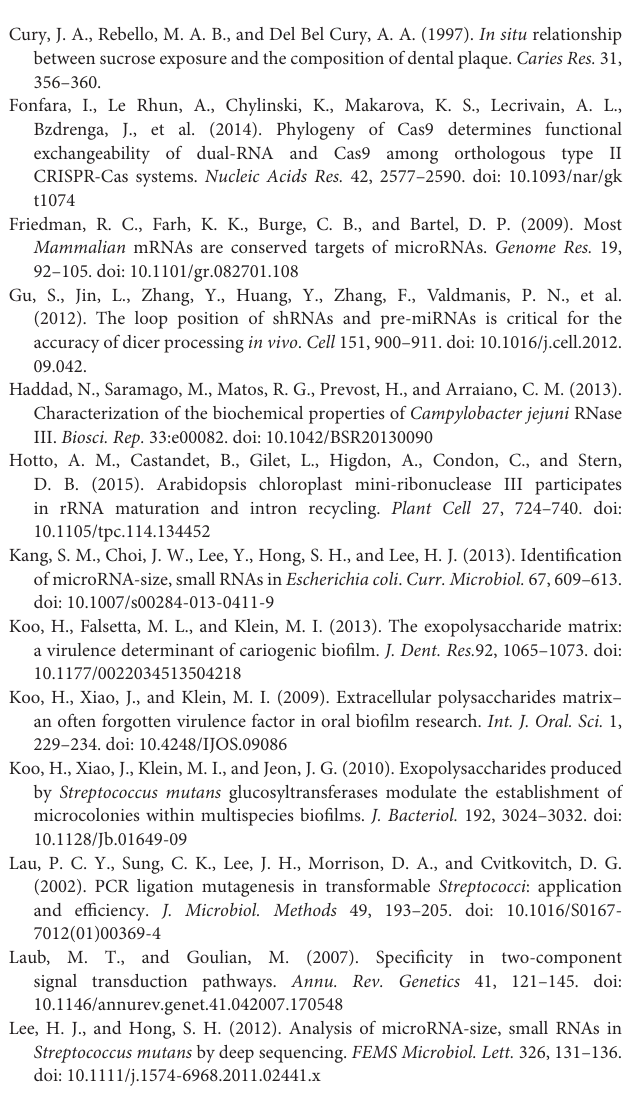
Table S1 | Bacterial strains, plasmid, and amplicons used in this study. Table S2 | List of oligonucleotide primers used in this study. Table S3 | Sequences of primers used for stem-loop qRT-PCR analysis.